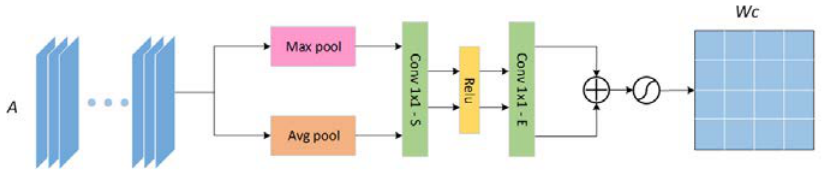
Figure 4. The architecture of the channel attention mechanism (CAM) module.